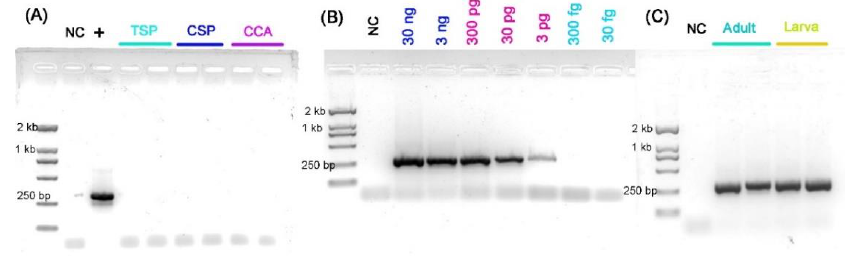
Figure 7. Species-specific PCR assay results with two SS- COI primers. ( A ) Species-specificity test of T. japonensis SS- COI primers. ( B ) Identification of the detection limit of gDNA in the species-specific PCR assay from 30 ng to 30 fg. ( C ) Species-specific PCR assay results with genomic DNA extracted from larvae and adults. NC: negative control, +: T. japonensis , TSP: Thecodiplosis sp., CSP: Contarinia sp., CCA: C. caryafloralis